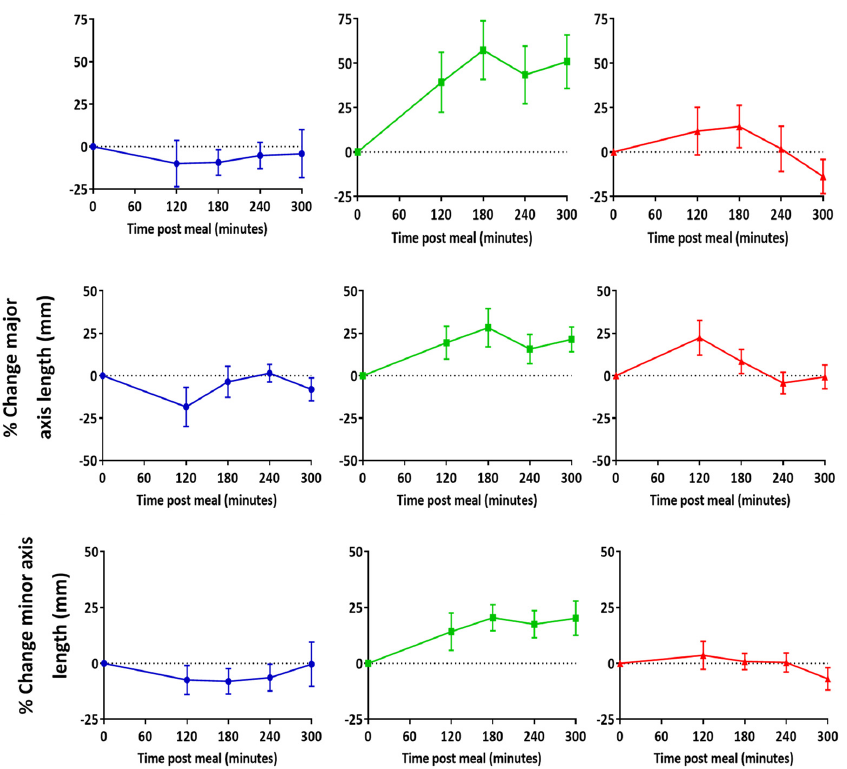
Figure 4. Change in lymph node area, major, and minor axes length relative to baseline post high fat meal. Data represent mean ± SEM of all nodes that were consistently imaged across all time points. n = 11 for participant 1, n = 22 for participant 2, and n = 33 for participant 3.